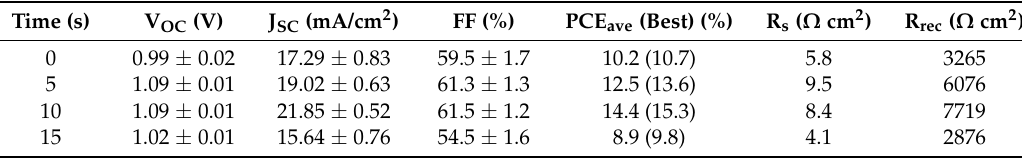
Figure 3. ( a ) The cross-sectional view of glass/FTO/TiO 2 /MAPbI 3 /spiro-OMeTAD/Ag planar heterojunction perovskite solar cell; ( b ) J-V curves and ( c ) incident photon-to-electron conversion efficiency (IPCE) spectra and integrated current density of the perovskite solar cells (PSCs) at different MA treatment times; ( d ) The impedance spectra of different MA treatment times of PSCs under 0.6 V applied bias in dark, the inset picture is the equivalent circuit. Table 1. Parameters of Current Density-Voltage Measurement and Electrochemical Impendence of the PSCs at different MA treatment times.